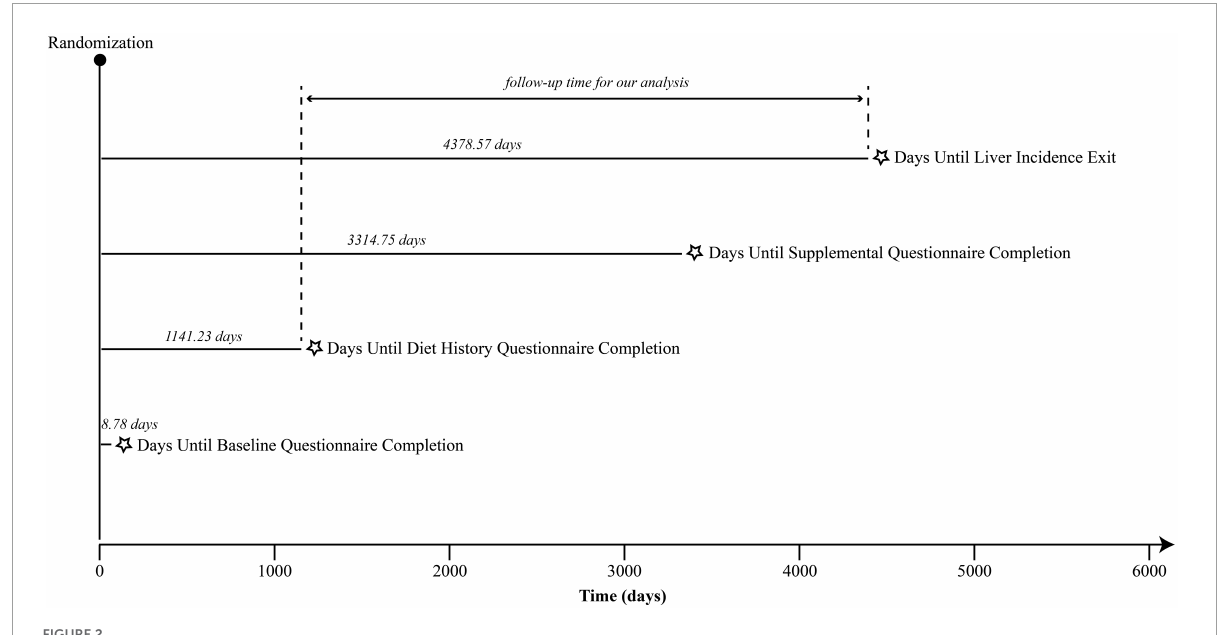
FIGURE2 The timeline and follow-up scheme of our